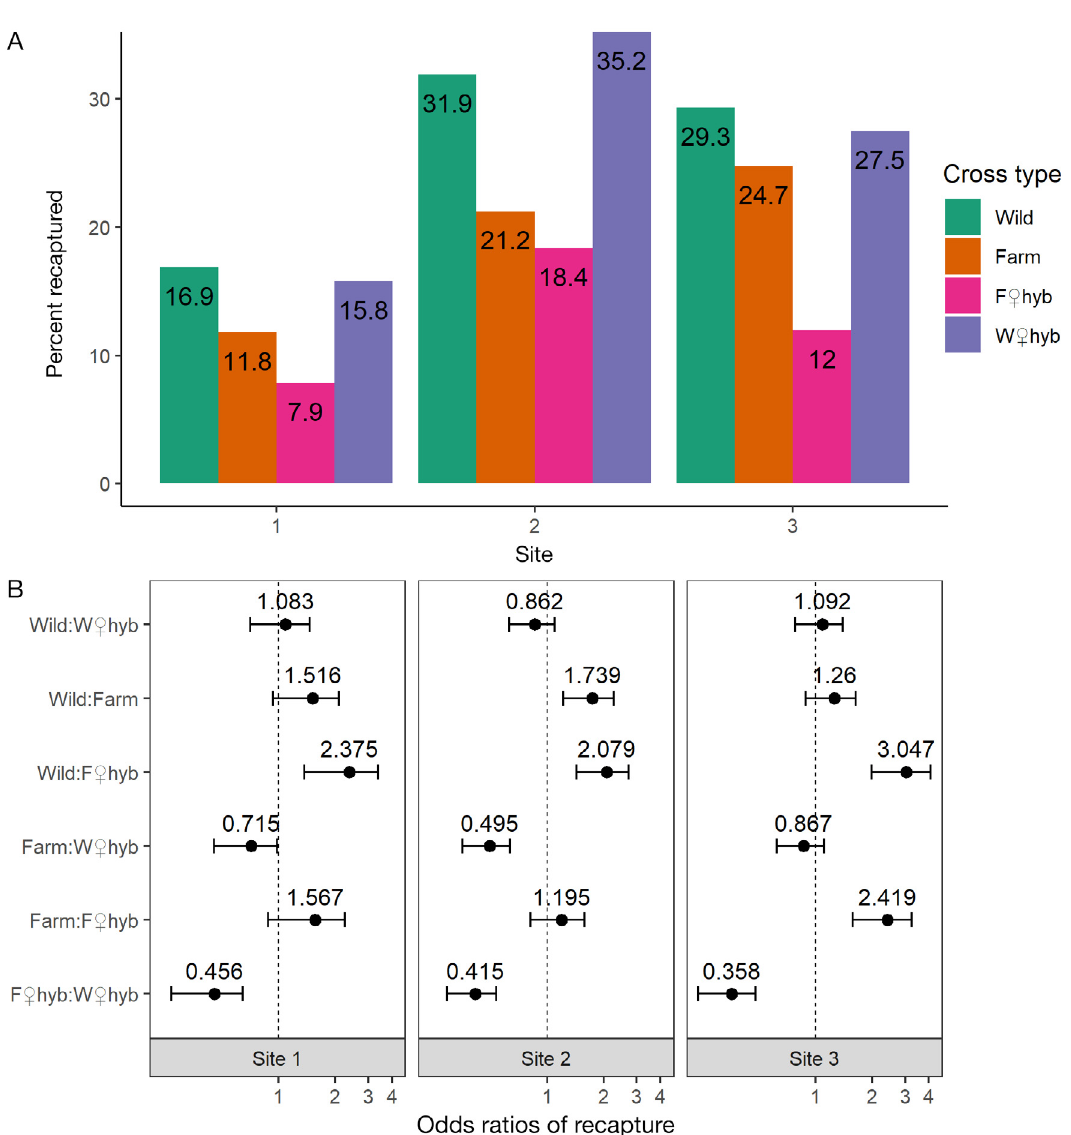
Fig. 3. (A) Percentages of Atlantic salmon recaptured by cross type and site and (B) odds ratios of recapture for pairwise cross type combinations at each site. Error bars in (B) represent ±2 SE of the odds ratio estimates. Odds ratios and SE were